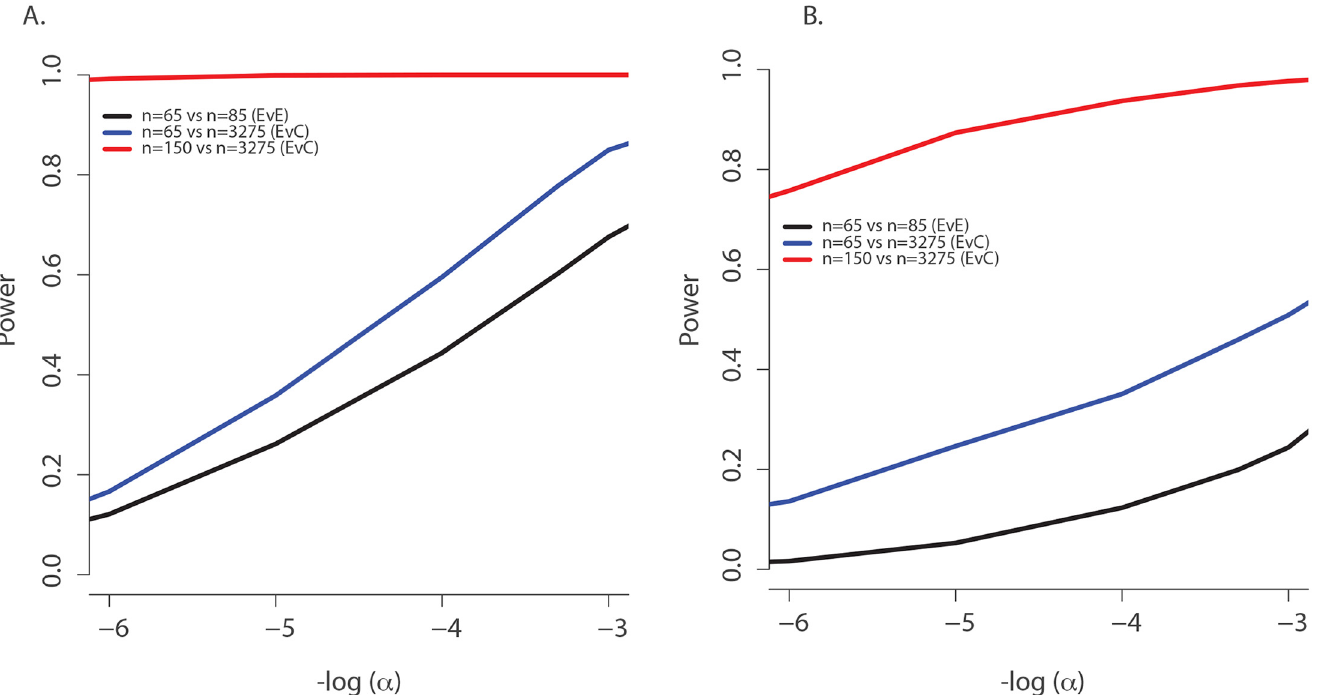
Fig 5. Power to discover TMC6 with aSKAT-O for a test of size α under the actual ages of the individuals in the extreme samples in this study. ( A ) Power to detect a difference between groups at TMC6 rs34712518 for three study designs based on the allele distributions for actual ages of individuals in the extremes in this study: extreme phenotypes (i.e. extreme versus extreme; black); the single extreme versus population control study reported here (blue); hypothetical single extreme versus control study if all exome resources had been devoted to the late onset extreme, which provides near 99% power to detect this variant (red). ( B ) Power to detect a difference between groups for TMC6 by-gene assuming the observed allele frequencies in the validation set (for CF individuals) and in ESP controls. Study designs are the same as in (A). The power of the single extreme versus control design to detect TMC6 at the exome-wide significance level of 2x10 -6 is approximately 20% (blue), which is an order of magnitude higher than that of the extreme phenotypes design (black), while devoting all exomes to one extreme would provide nearly 80% power